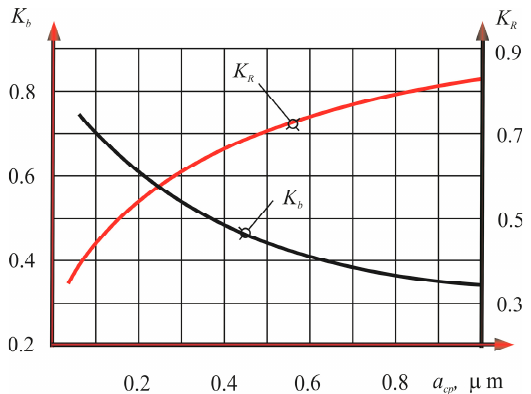
Figure 4. The effect of cutting depth: scratching by abrasive bar grains by 36 CM BB Π on the extrusion coefficient and the coefficient of excess surface roughness: V K = 35 m · min − 1 ; V w = 20 m · min − 1 ; S = 1.0 m · min − 1 ; t x = 0.05 mm · unit − 1